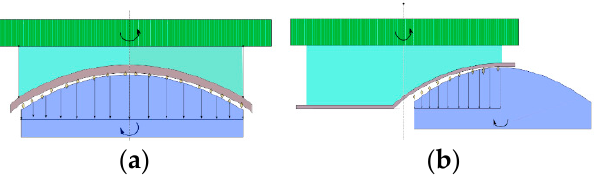
Figure 22. Pressure acting on the workpiece. ( a ) Pressure distribution at the center. ( b ) Pressure distribution at the edge.